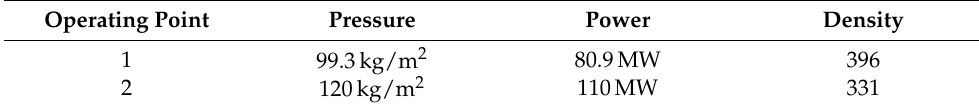
Table 1. Operating points for the boiler-turbine